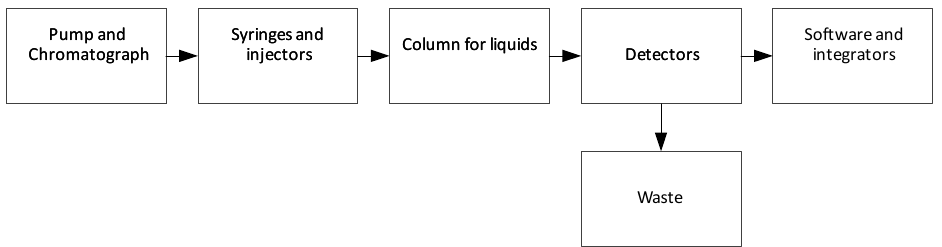
Figure 5. Elements that integrate a high-performance liquid chromatograph.